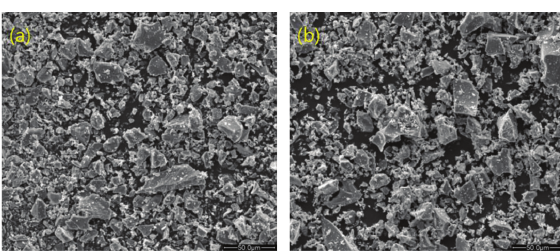
Figure 1: Morphology of FNS: (a) EFS and (b) BFS [3].